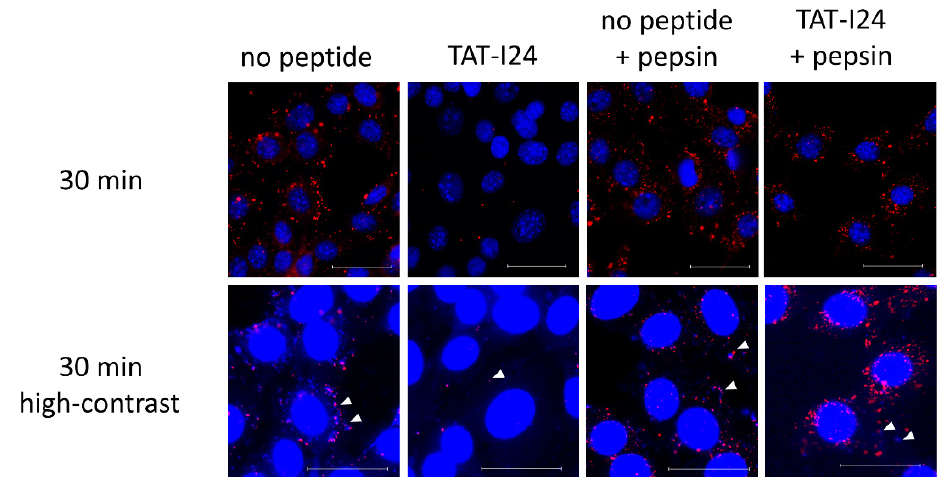
Figure 7. Localization of BrdU-labelled MCMV DNA in NIH/3T3 cells 30 min post-cold release. Cells were left untreated or incubated with TAT-I24 during MCMV adsorption. Cells were fixed and permeabilized before staining with BrdU-antibody (red fluorescence). Nuclei were additionally stained with DAPI (blue fluorescence). One group was treated with pepsin for 20 min after fixation and permeabilization followed by staining with the BrdU antibody. The lower panel shows enlarged images at high contrast settings (40× objective). Arrows indicate co-localization of blue fluorescence (DAPI) and red fluorescence of BrdU-labelled viral DNA. Scale bar indicates 40 µm.